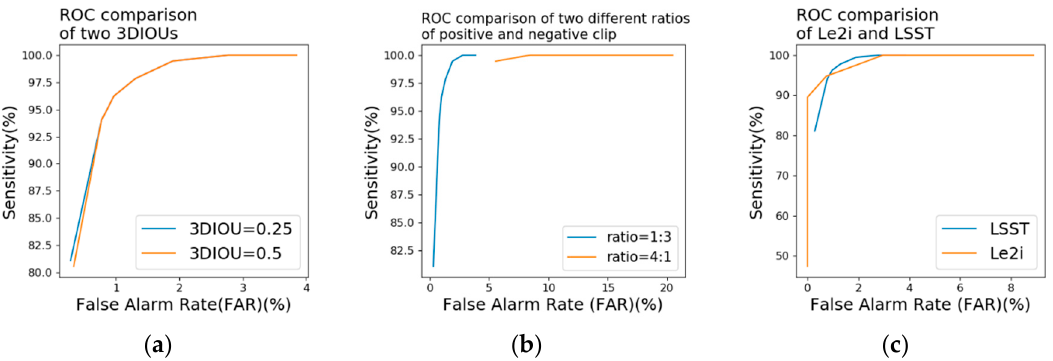
Figure 5. Receiver operation characteristic (ROC) comparison of three ablation studies. ( a ) ROC comparison between 𝛿 = [0.25] and 𝛿 = [0.5] ; ( b ) ROC comparison between positive and negative clips with a ratio of 1:3 and positive and negative clips with a ratio of 4:1; ( c ) ROC comparison between large-scale spatio-temporal (LSST) and Le2i.